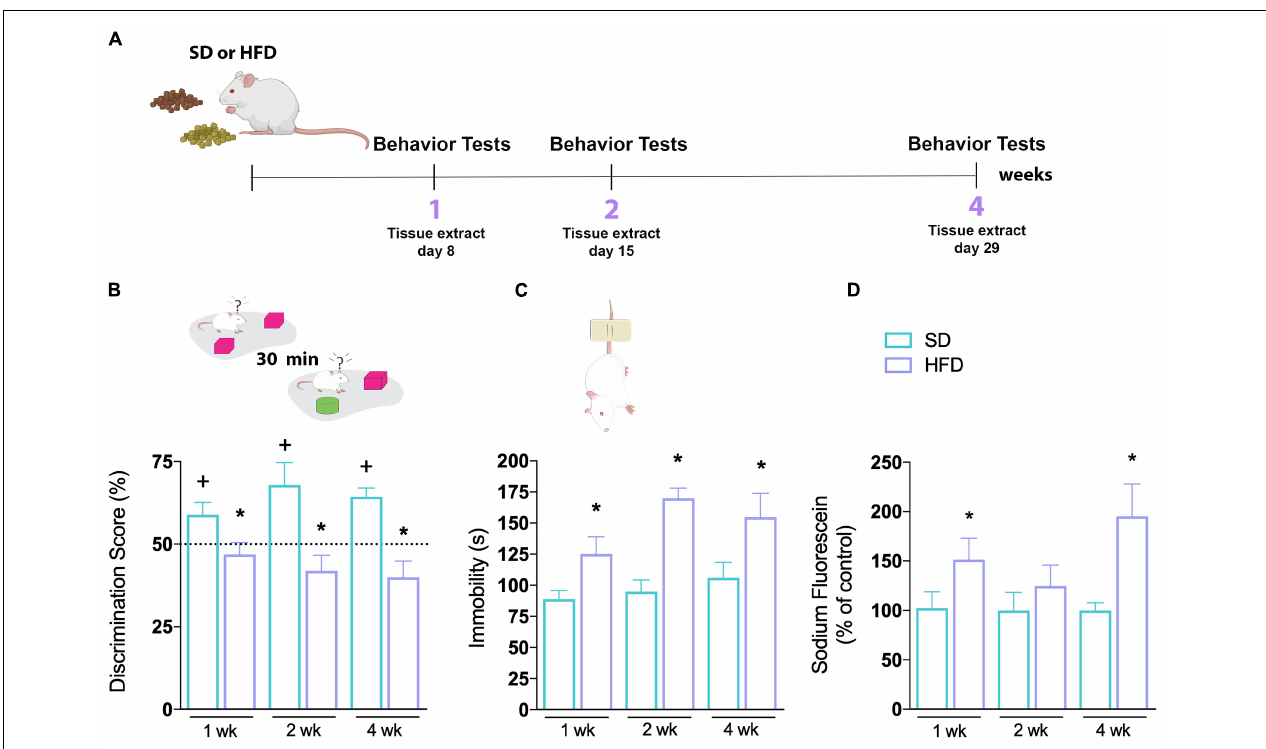
FIGURE 1 | Hippocampal abnormalities of mice fed a high-fat diet. (A) First time-course experimental design. (B) Novel object recognition (NOR) and (C) tail suspension tests (TSTs) were performed in mice fed SD or HFD for 1, 2, and 4 weeks. Cognitive performance of SD and HFD-treated mice was accessed by NOR ( n = 7–8/group; one-sample t- test with hypothetical value of 50%). Time of immobility in TST was recorded in order to evaluate depressive-like behavior ( n = 7–8; unpaired t -test for 1, 2, and 4 weeks of diet, respectively). (D) Sodium fluorescein assay to evaluate BBB permeability on hippocampus ( n = 5–7; t -test for 1, 2, and 4 weeks of diet). Values are mean ± SEM. + Means higher than the hypothetical value of 50%, * p < 0.05 SD vs. HFD, + discrimination score above